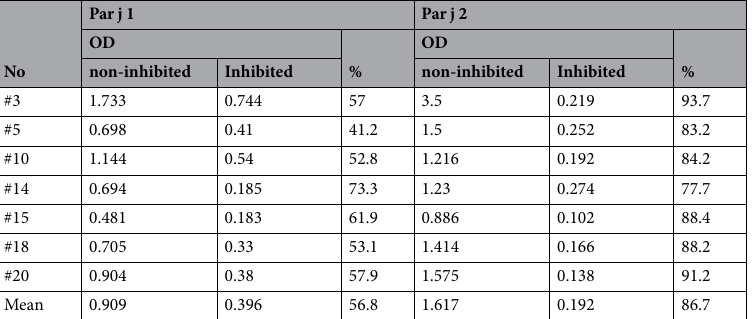
Table 1. Inhibition of allergic patients IgE binding to Par j 1 and Par j 2 with rabbit anti-Par j 2 antibodies. Shown are optical densities (OD) corresponding to bound IgE antibodies and calculated percentages of IgE